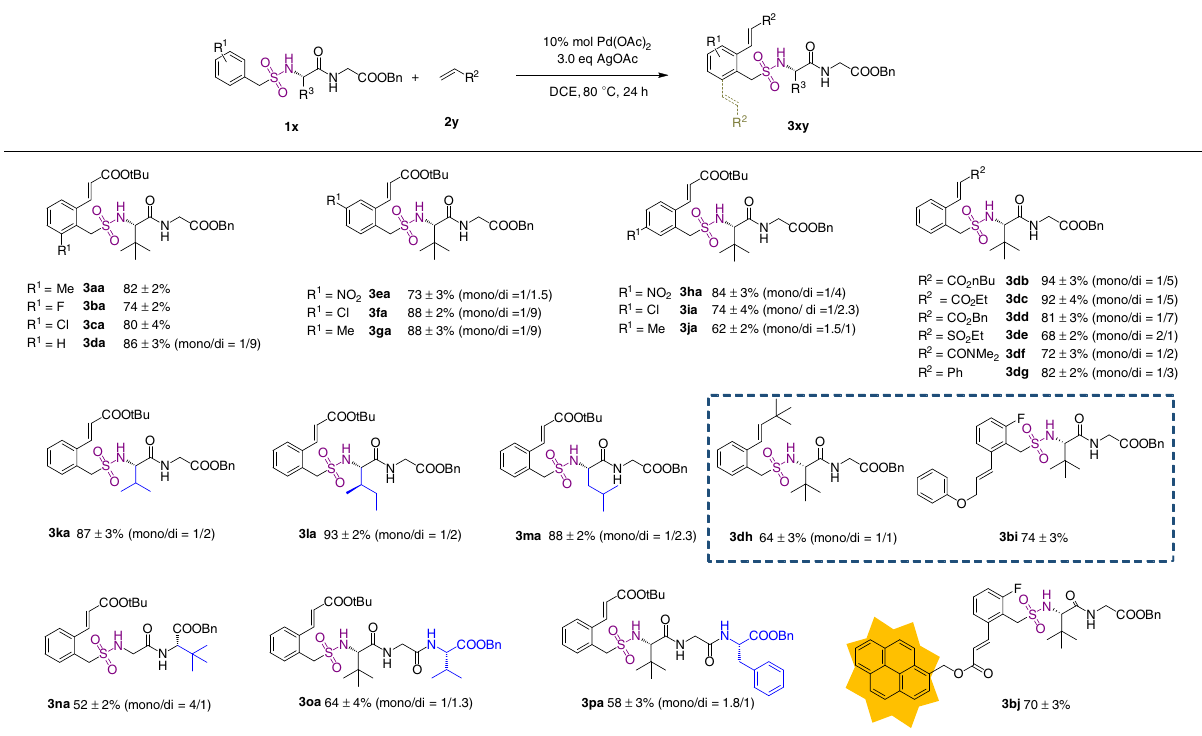
Fig. 2 Scope of the ole fi nation reaction of benzylsulfonamide peptide conjugates. The isolate yields were determined by three repeats of the